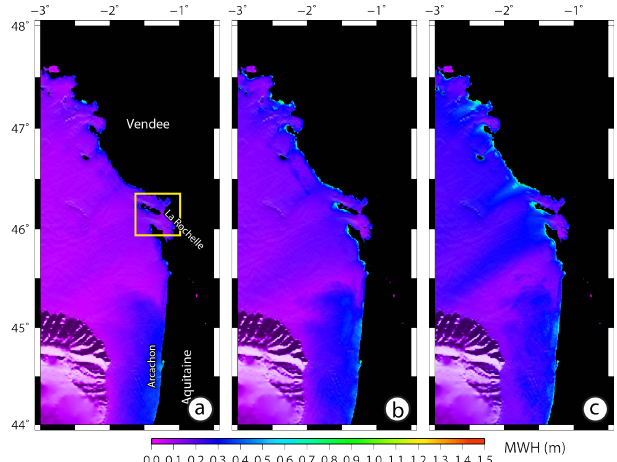
Figure 8. Maximum wave height maps obtained after 12h of prop- agation showing coastal amplifications close to the French Atlantic coastline (grid 6) for the 3 scenarios. From left to right, scenar- ios 1 (a) , 2 (b) , and 3 (c) . The yellow rectangle shows the position of the grid